Question: In a single sentence, describe what this figure presents.
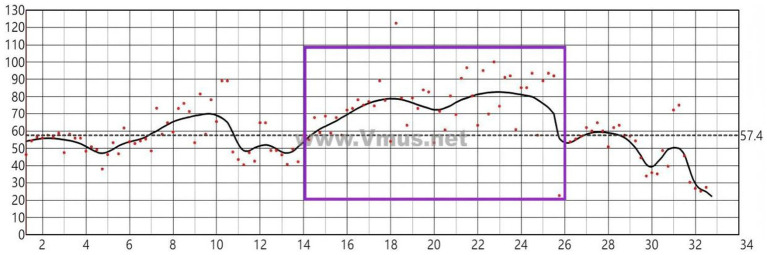
Answer: Maurizio Pollini Macro Tempo Curve.